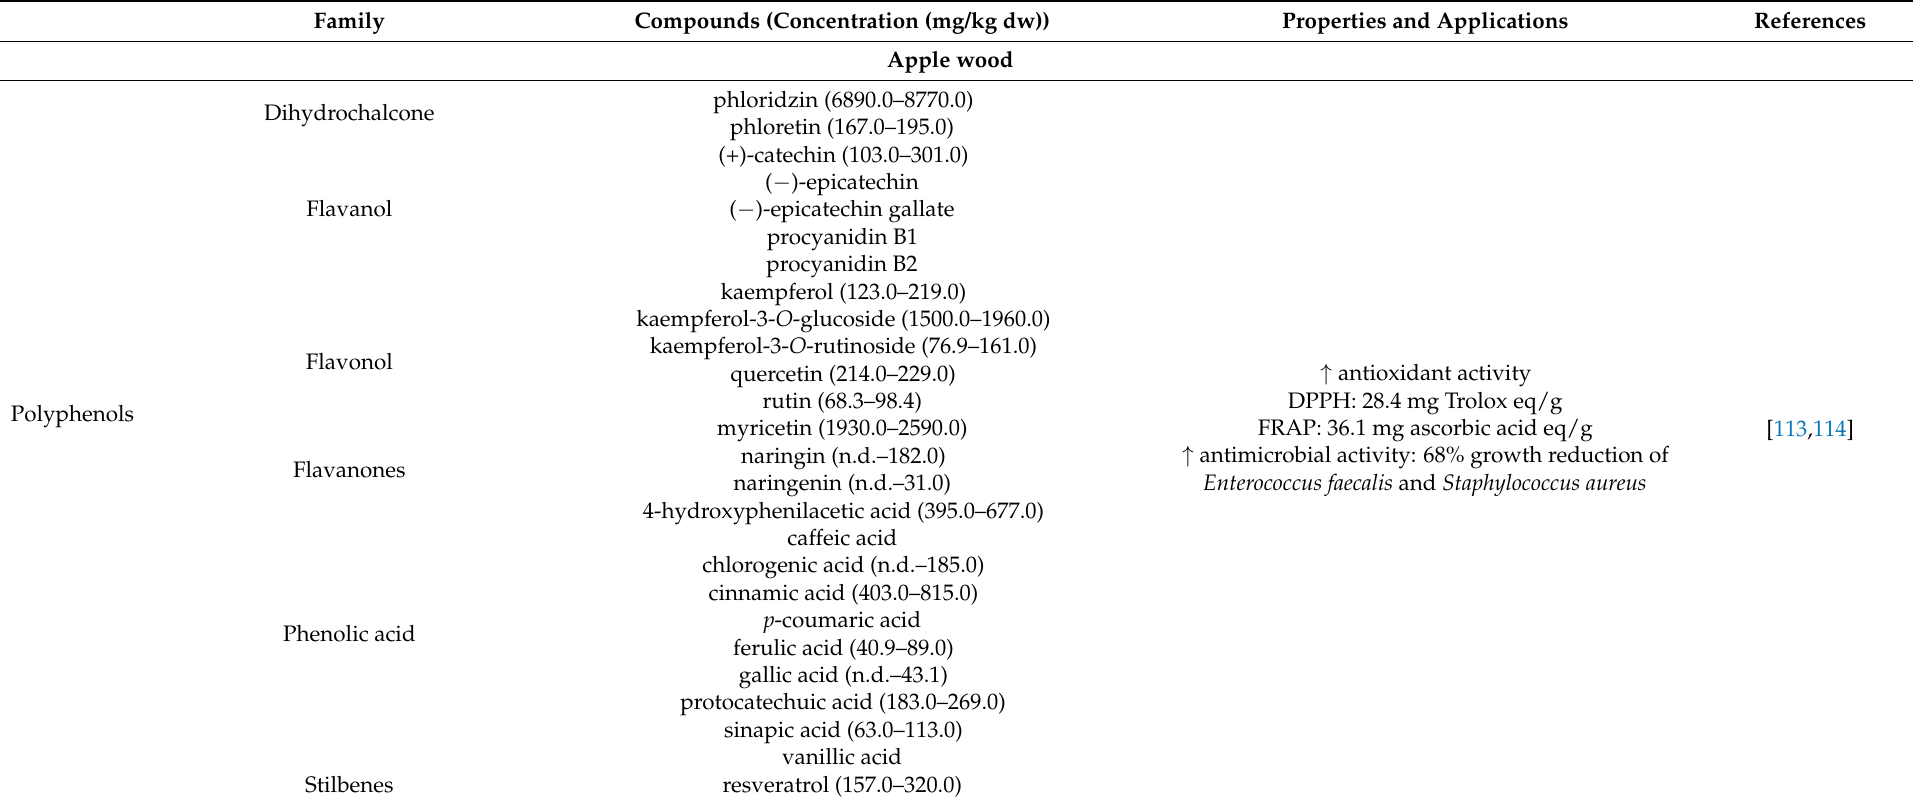
Table 4. Main bioactive compounds (mg/kg dry wood) from apple tree wood and their applications. * ↑ : Increase. Chemical structures by families are shown in Figure